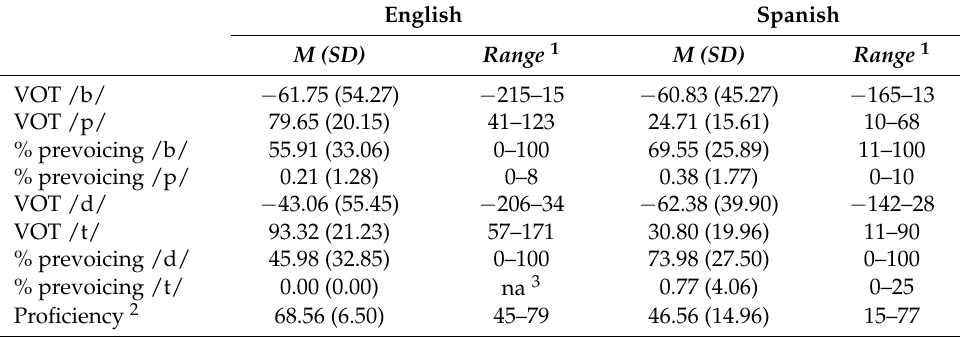
Table 1. Descriptive statistics for production and proficiency